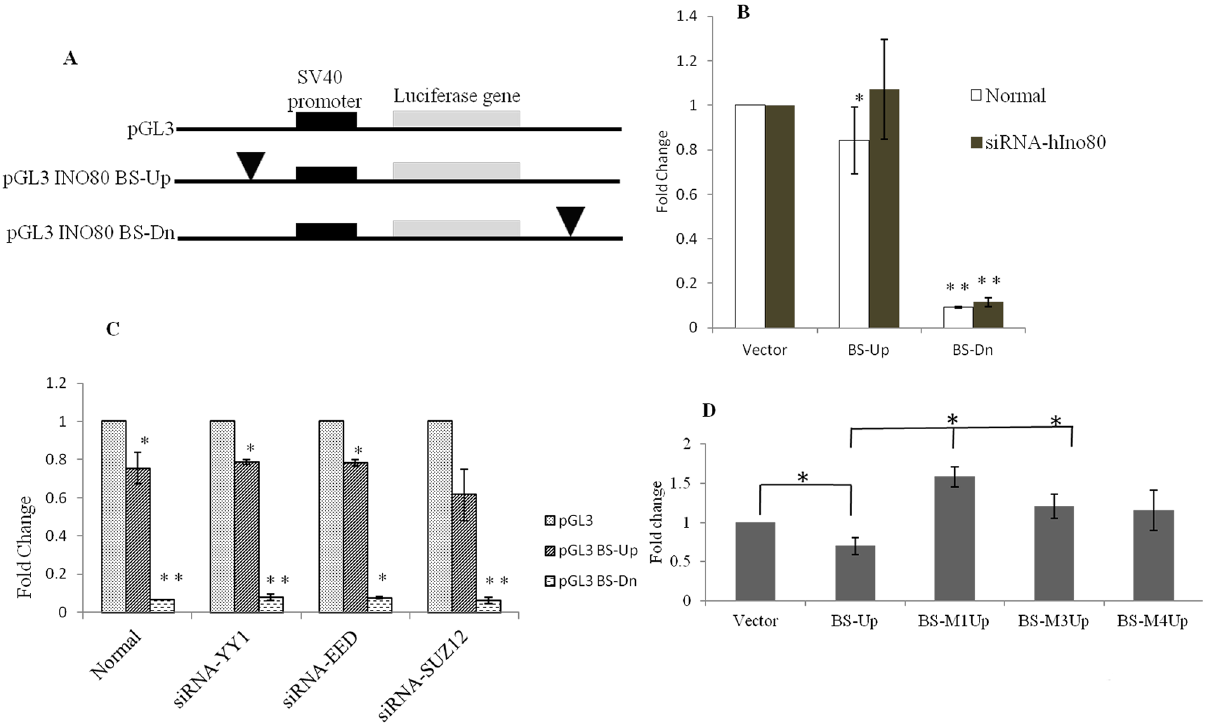
Fig 6. Effect of INO80 binding on expression of luciferase reporter gene in HEK293T cell line. (A) Diagrammatic representation of the constructs used in the luciferase reporter assays. The constructs are; pGL3 promoter vector without the INO80 binding site, pGL3INO80 BS-Up (BS-Up) where the INO80 binding motif is cloned upstream of the promoter of luciferase reporter gene and pGL3INO80 BS-Dn (BS-Dn) where binding motif is cloned down-stream of the poly(A) signal. (B) The effect of INO80 binding on the expression of reporter gene under normal and knock-down of hINO80 condition in HEK293T cells. The reporter expression is indicated as fold change with reference to expression from pGL3 vector. The firefly luciferase counts were normalized with renilla luciferase counts. (C) The effect of knock-down of PRC members on reporter expression. The constructs pGL3, pGL3 BS-up and pGL3 BS-Dn were transfected in cells treated with siRNA-YY1, siRNA-EED and siRNA-SUZ12. (D) The effect of the mutant oligos (Fig 5A) on reporter expression. The error bars represents the standard deviation ( * p value < 0.05 and ** p <